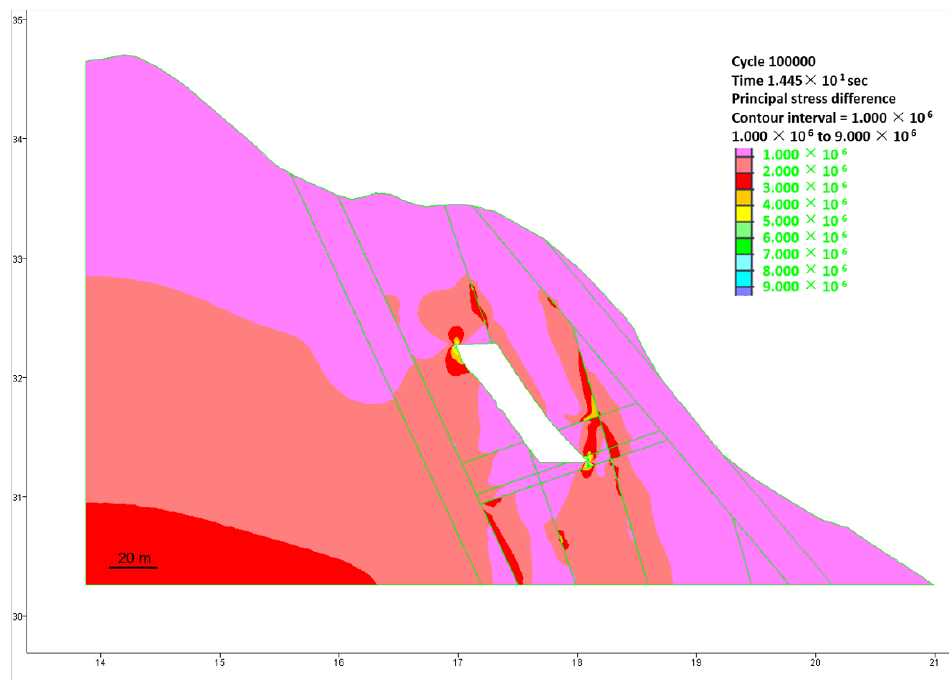
Figure 23. Deviatoric stress ( σ 1 – σ 3 ) of Section 1 calculated in Pa.